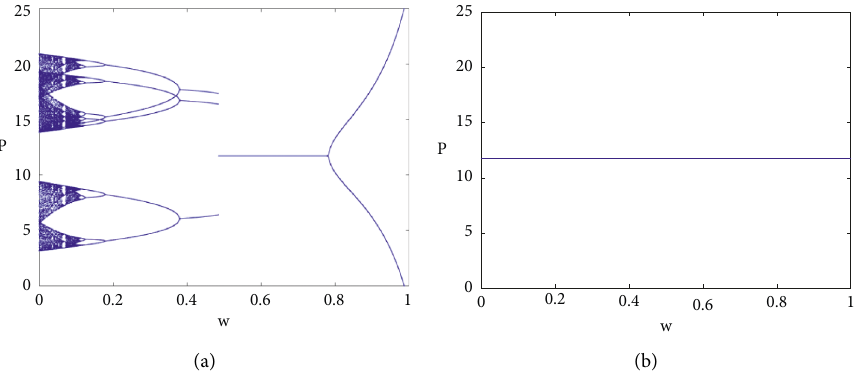
Figure 2: Bifurcation diagrams of the parameter w, with all other parameters fixed at a = 8, b = 0.44, c = 2, d = 9.6, e = 1.5, γ = 0.089, ε = 0, and R = 1.0186. The figures show the existence of single or multiple stable steady states or even chaotic price dynamics under different w-values. The w appears in (1) and (15), denoting the weight of the latest market price in producers’ price expectation formation. (a) In the original ABM with speculators, nonlinear price dynamics show various phenomena, such as pitch-fork bifurcation (w = 0.7703), period-doubling bifurcation (0.109 < w < 0.3812), and chaos (w < 0.1098). (b) In the degenerate case without speculators, one single stable steady state of the market price exists under different values of